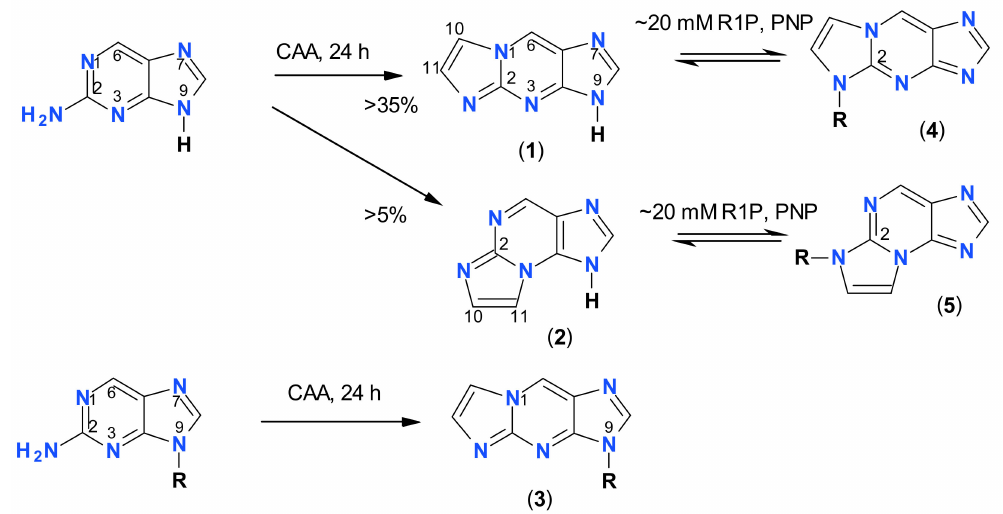
Figure 13. Synthesis of 2-aminopurine etheno-derivatives and their ribosides (R = β - d -ribofuranosyl; CAA = chloroacetaldehyde, R1P– α - d -ribose-1-phosphate; PNP = purine-nucleoside